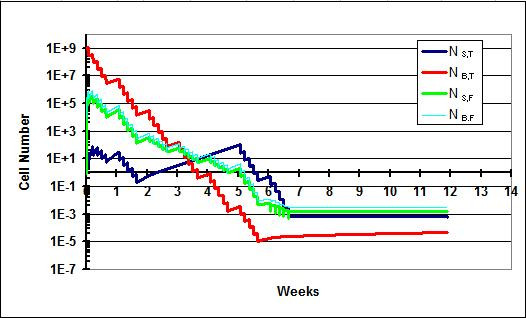
Scenario III. Treatment results when the value of kadh and kshed are lowered. Despite the treatment break of three weeks, cure is nonetheless achieved.